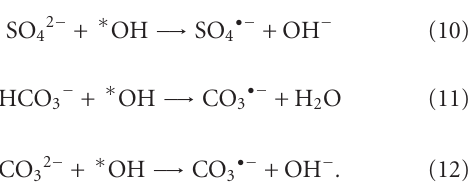
Figure 10: Investigation of the e ffi ciency of 1.5mol% Sn/TiO 2 in mineralization of AMOX from real water.